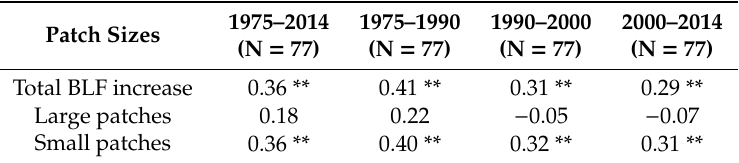
Table 4. Pearson correlation coefficients between the patch sizes of built-up land in floodplains and flood occurrence in the North China Plain Area.